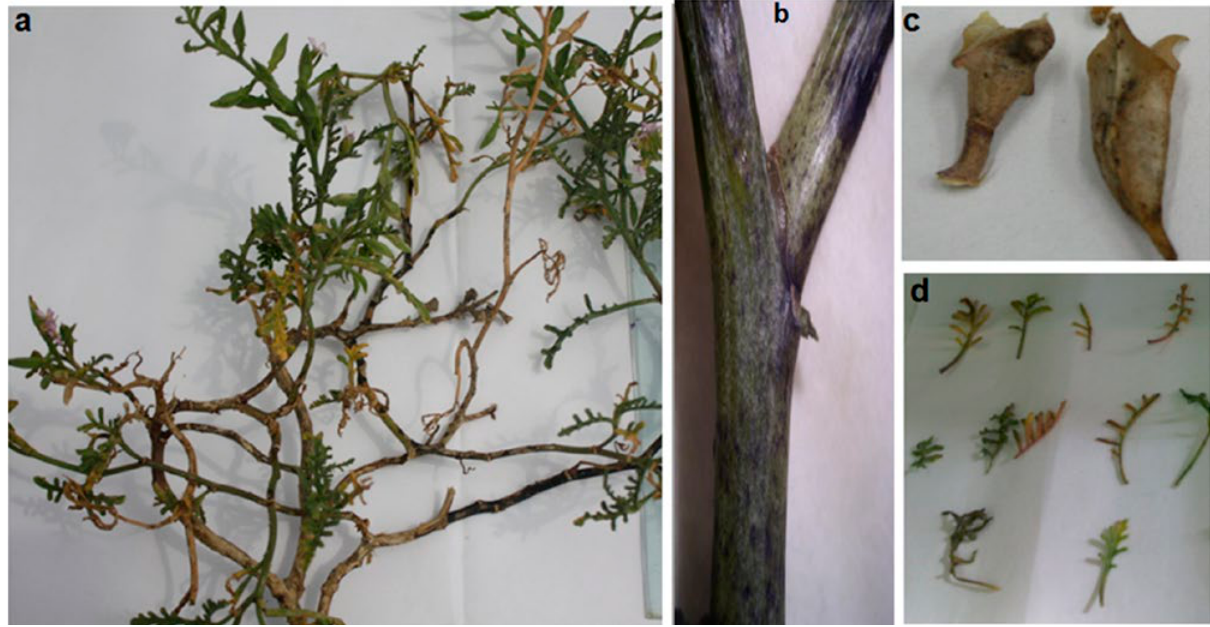
Figure 1. Symptoms of Alternaria infections on Cakile maritima . Whole plant (a), stem (b), seed (c)and leaves